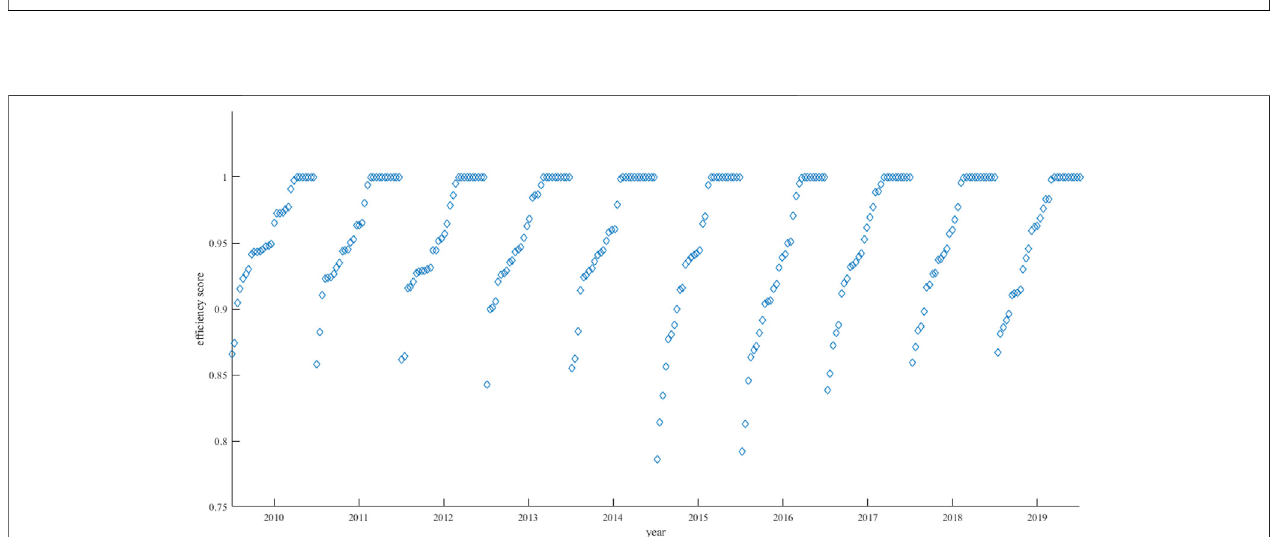
FIGURE 1 | Directional distance of the power sector of provincial administrative regions.